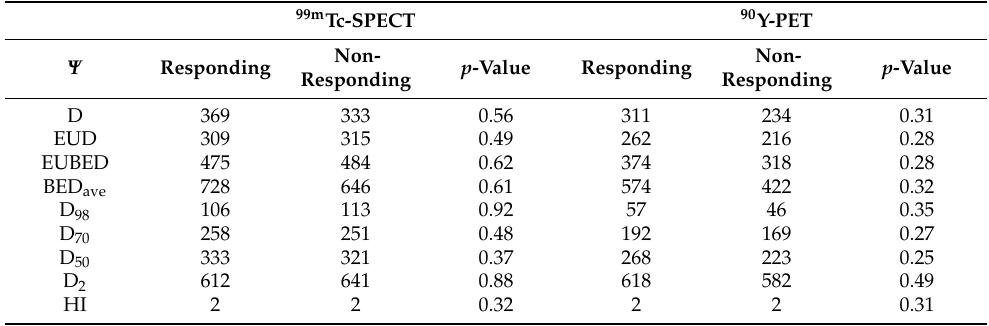
Figure 2. The 99m Tc-MAA SPECT/CT ( a , c ) and 90 Y-PET/CT ( b , d ) mean dose D distribution for responding and non-responding lesions. Response was evaluated with mRECIST ( a , b ) and the densitometric method ( c , d ). Table 5. Median Ψ values (in gray, except HI) and Mann–Whitney p -values for responding and non-responding lesions classified according to the mRECIST